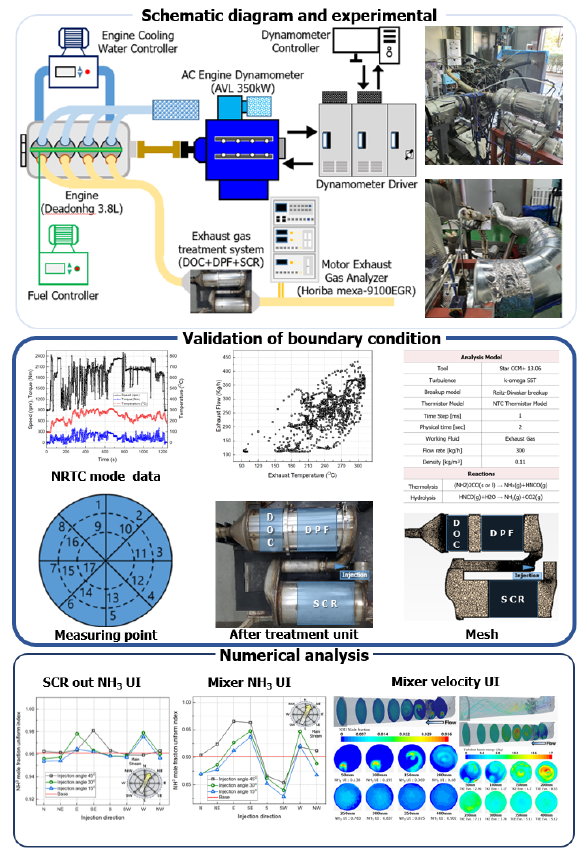
Figure 1. Design optimization procedure of the urea injection angle and direction of the selective catalytic reduction system.